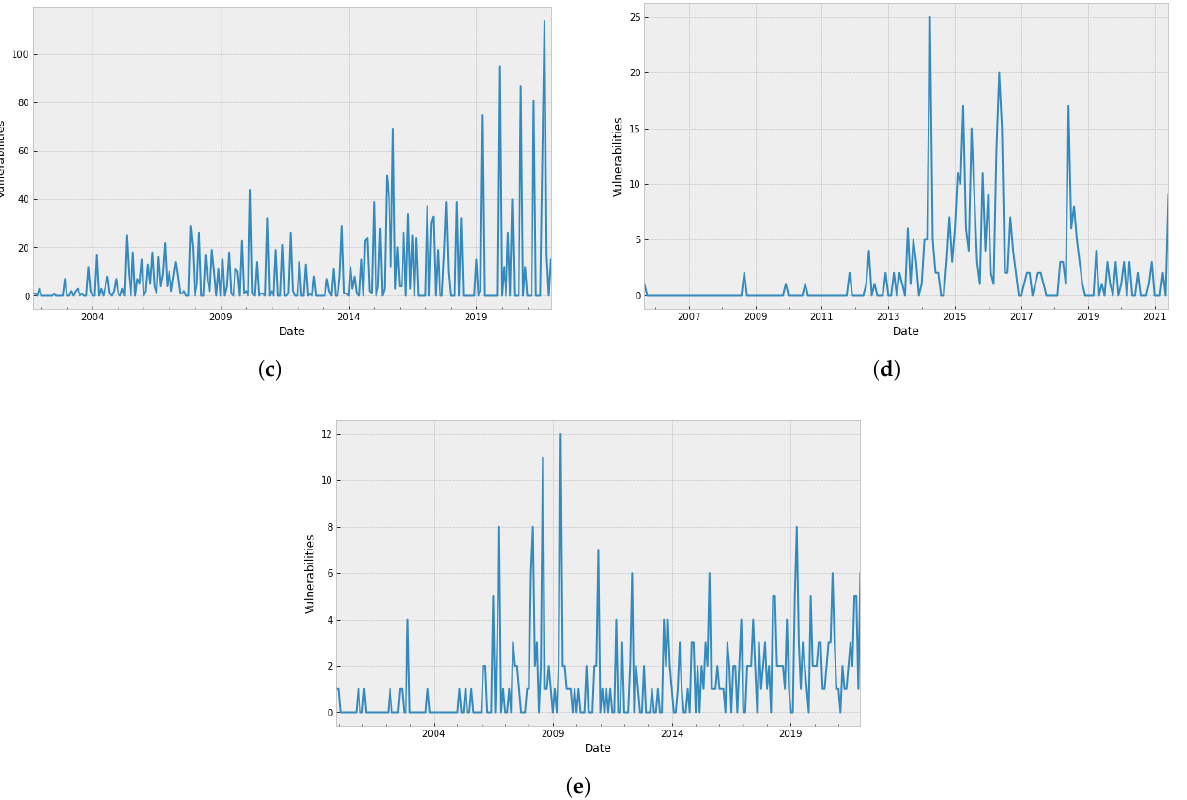
Figure 2. Vulnerability evolution of the five selected projects. ( a ) Google Chrome; ( b ) Internet Explorer; ( c ) Apple macOS X; ( d ) Ubuntu Linux; ( e ) Microsoft